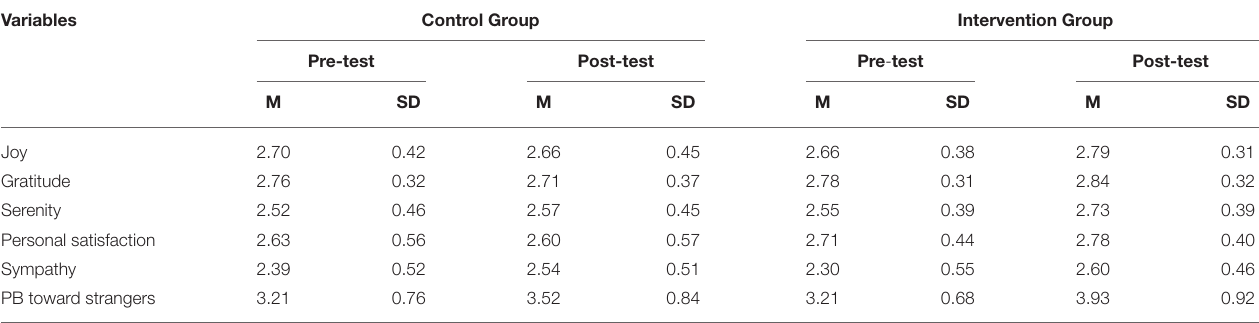
TABLE 1 | Means and standard deviations of positive emotions (joy, gratitude, serenity, personal satisfaction, and sympathy) and prosocial behavior in the pre-test and post-test evaluations. Variables Control Group Intervention Group Pre-test Post-test Pre - test Post-test M